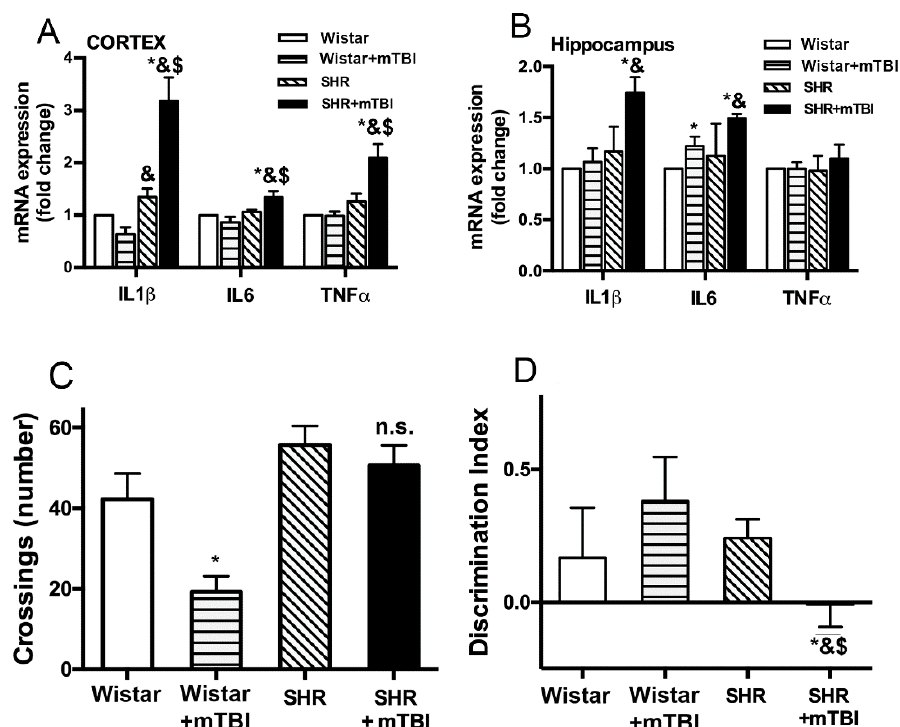
Figure 2. Mild TBI induces persistent neuroinflammation and cognitive decline in hypertensive rats. ( A , B ) mRNA expression of inflammatory cytokines IL1 β , IL6 and TNF α in cortical ( A ) and hippocampal ( B ) tissue of sham operated normotensive Wistar rats and SHRs, and of animals two weeks after mild TBI, expressed as fold change compared to control. Data are means ± S.E.M. ( n = 8 in each group) * p < 0.05 vs. Wistar, & p < 0.05 vs. Wistar + mTBI, $ p < 0.05 vs. SHR. ( C ) In a standard open field test normotensive Wistar animals showed attenuated exploratory activity (number of crossings) two weeks after mTBI (Wistar + mTBI) indicating habituation to the environment and intact locational memory function. In contrast, SHRs did not show habituation to the environment in the repeated open field test (OFT) session two weeks after mTBI (SHRmTBI), indicating impaired locational memory. Data are means ± S.E.M. ( n = 15 in each group) * p < 0.05 vs. Wistar. ( D ) Intermediate-term declarative memory was tested two weeks after mTBI by the novel object recognition test. Discrimination index was not changed in normotensive Wistar rats two weeks after mTBI, but it was significantly decreased in SHRs, indicating impaired declarative memory of the animals. Data are means ± S.E.M. ( n = 5 Wistar and n = 11 SHR) * p < 0.05 vs. Wistar, & p < 0.05 vs. Wistar + mTBI, $ p < 0.05 vs.